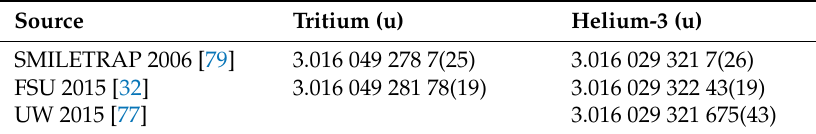
Table 4. Atomic masses of tritium and helium-3 as originally